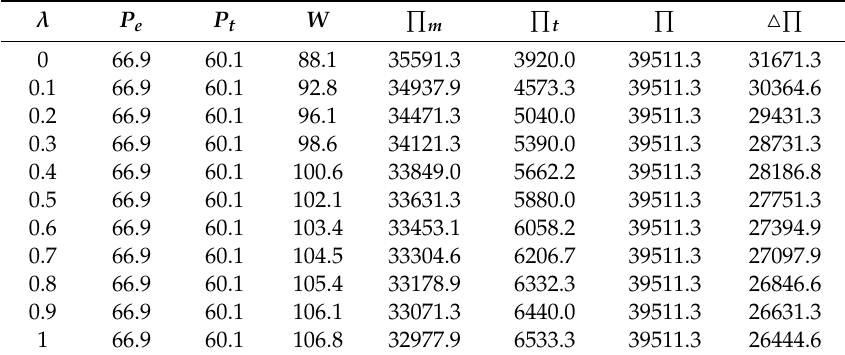
Table 2. The e ff ect of λ on decisions and